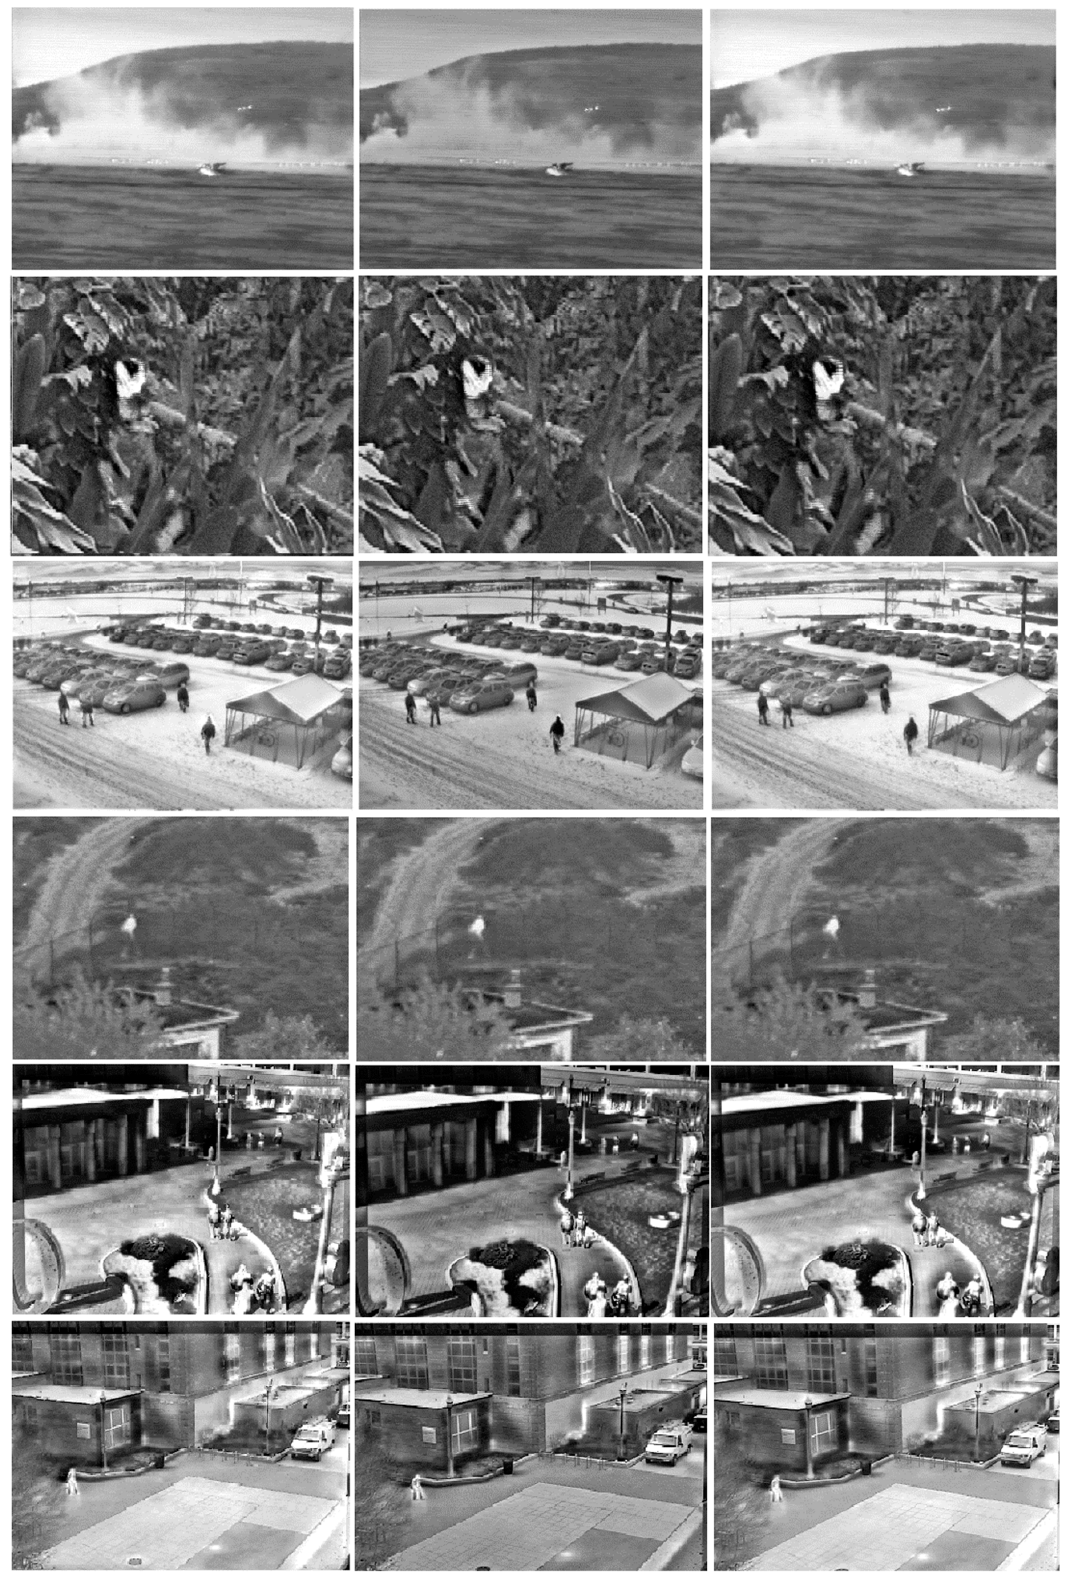
Figure 12. Fused images with Laplacian pyramid (left column), the middle Shift invariant discrete wavelet (SIDWT) (middle column) and proposed LAP-DIN fusion (right column).